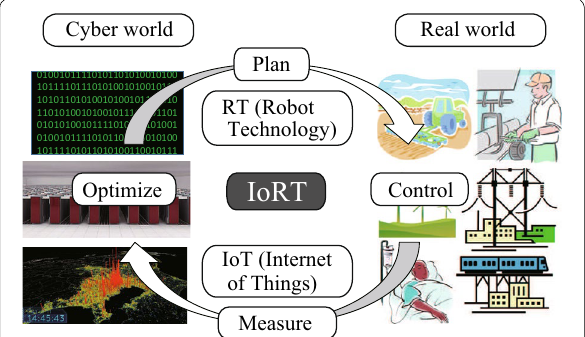
Fig. 1 Cyber physical system (CPS) and Internet of Thing and Robot Technology